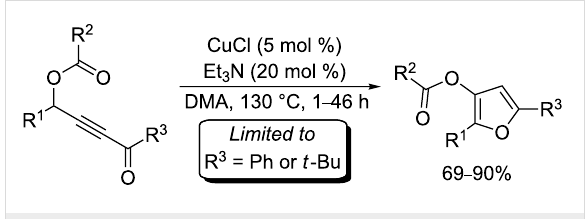
amine catalyzed the 1,2-migration/cycloisomerization of γ -acyloxyalkynyl ketones in dimethylacetamide (DMA) at 130 °C (Scheme 2) within 1–46 h [31,52,53]. Despite the